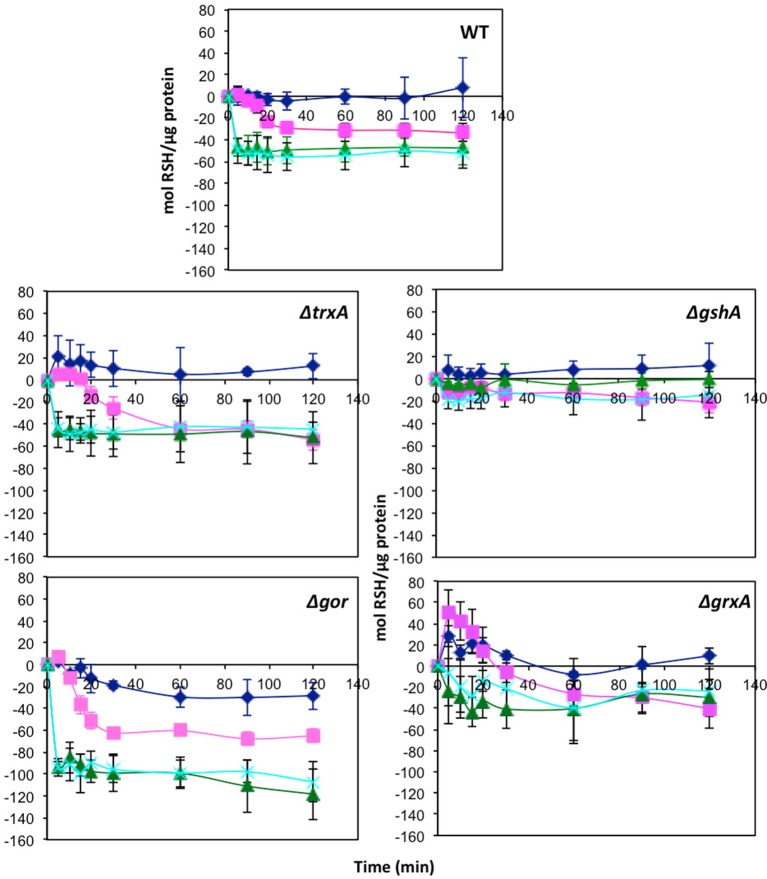
Change in reduced thiol pool in response to various metalloid challenges. Mid log phase cultures were exposed to metalloid challenges and their reduced thiol content was measured with time to evaluate the thiol oxidation rate. Control without challenge (blue diamonds), 1 μg/ml tellurite (red squares), 800 μg/ml selenite (green triangles), 1 μg/ml tellurite with 800 μg/ml selenite (cyan X). Wild type is in upper panel with each of four different redox balance mutants indicated. The error bars represent the standard deviation between 3 biological trials.